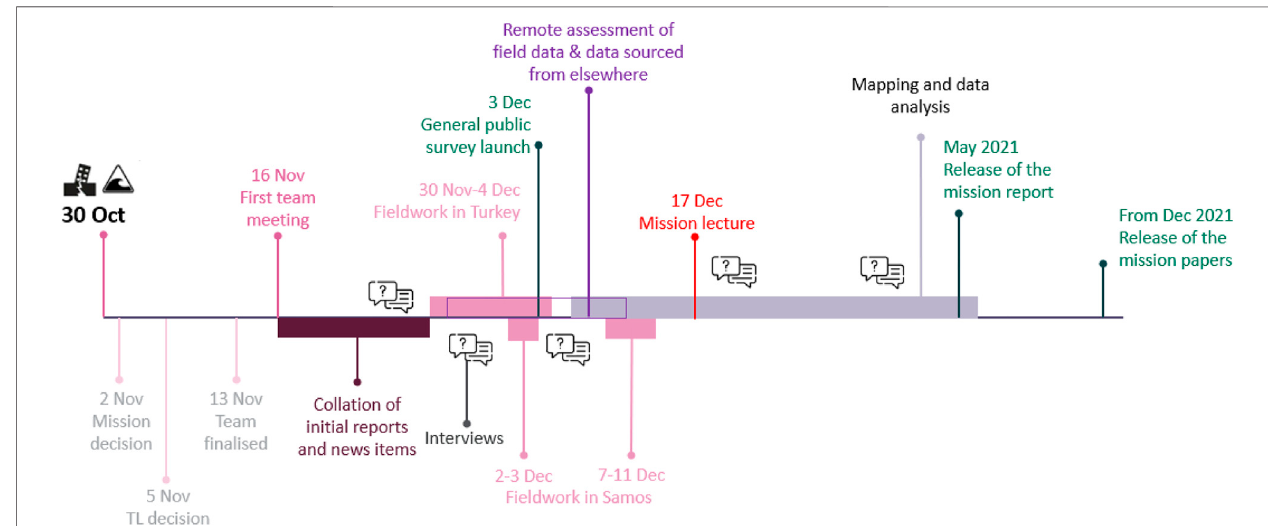
FIGURE 1 | 30 October 2020 Aegean Earthquake and Tsunami EEFIT Mission timeline.